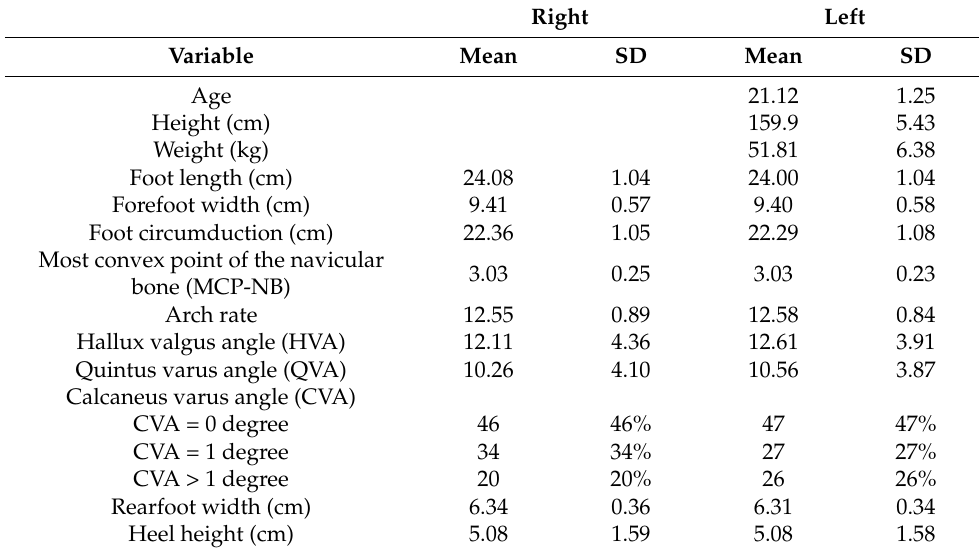
Table 1. Descriptive statistics for demographics.